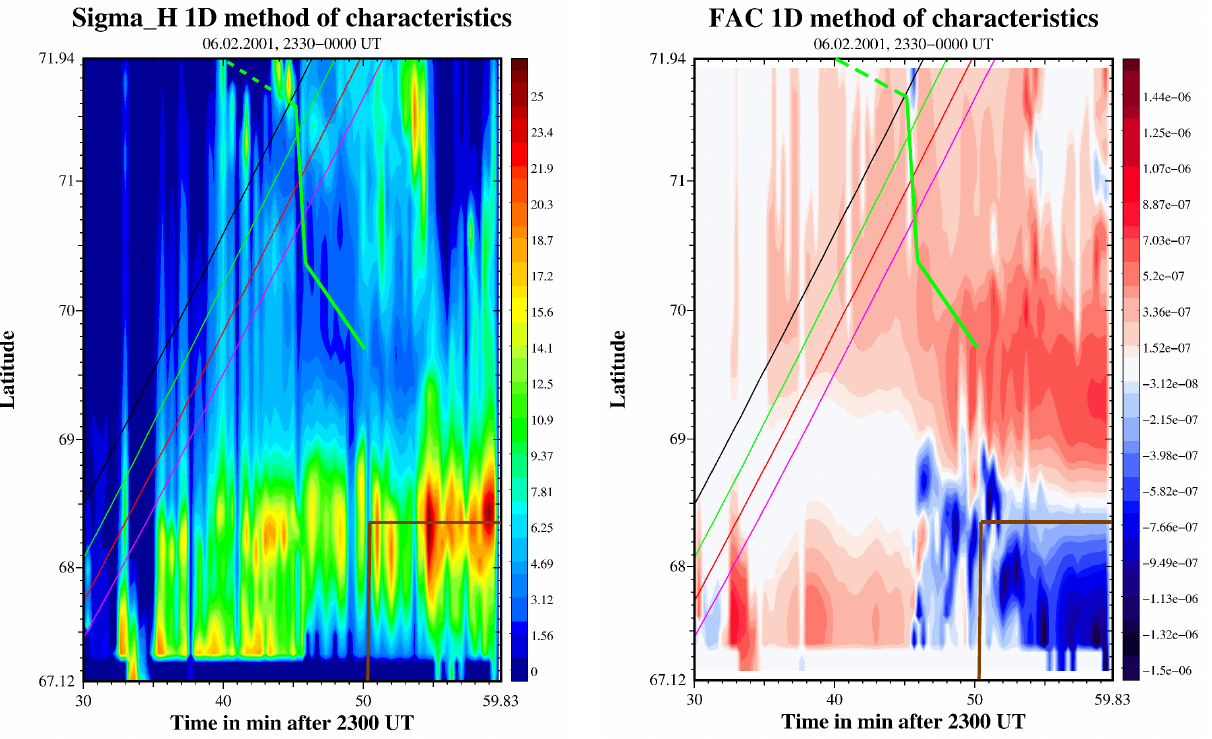
Fig. 6. Results of the 1-D method of characteristics for 6 H (left panel, in S), and FAC (right panel, in µ Am − 2 , positive values correspond to downward FAC), in the same format as Fig. 4 (left panel). The peak location of the westward electrojet (when entering the analysis region, compare Fig. 3) is schematically indicated by the brown